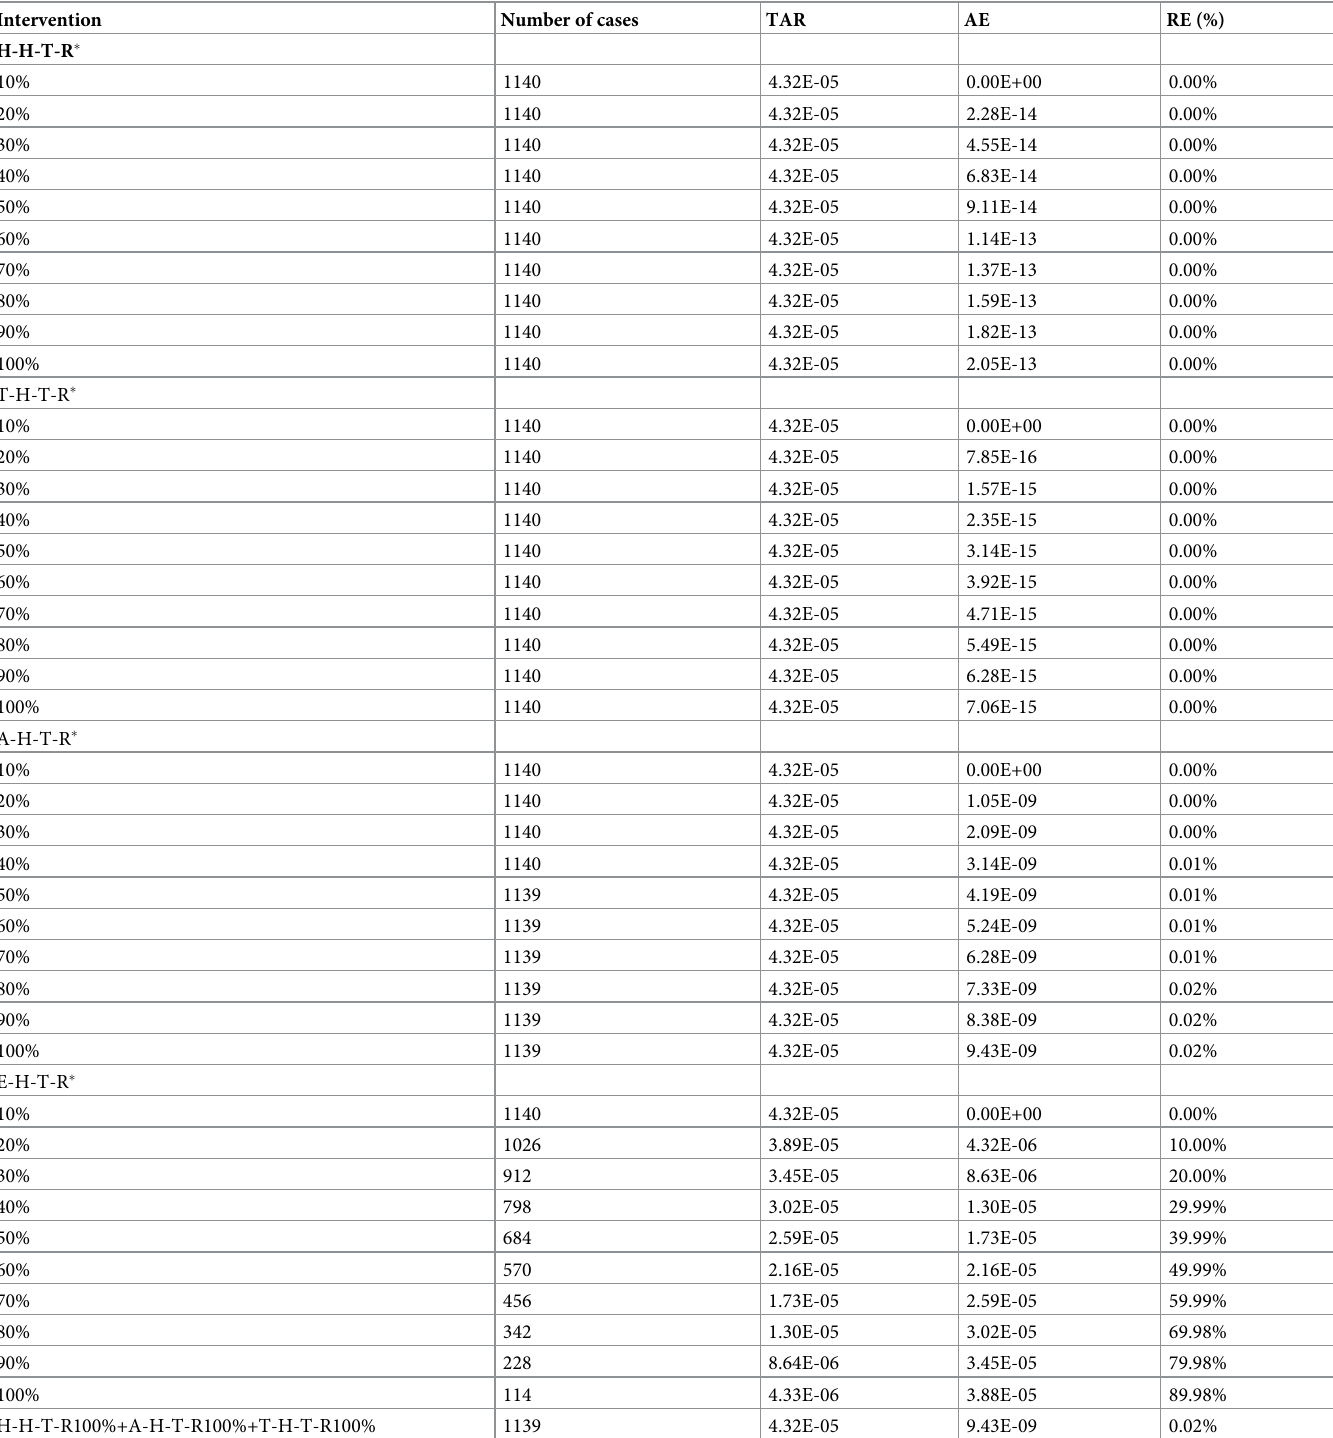
Table 2. Simulation of interventions for SFTS by the multi-population and multi-route dynamics model.